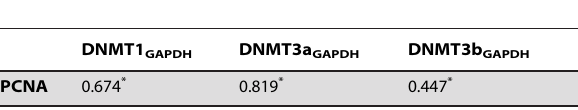
Table 3. Correlations between DNMTs and